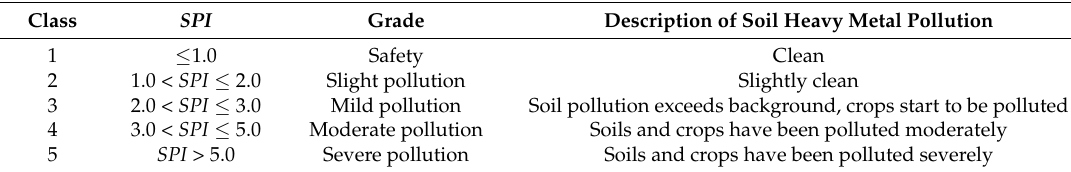
Table 1. Classes of the single pollution index (SPI).